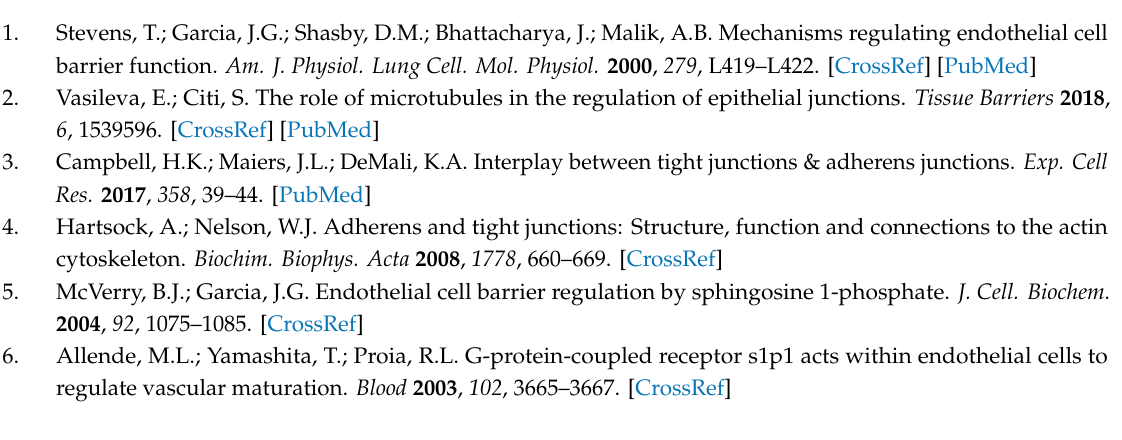
Figure S1: Dependence and reversibility of VE-cadherin assembly in HUVEC. Immunofluorescence staining of VE-cadherin in HUVEC after addition of 3 µ M S1PR1 antagonist W146, followed by removal of the added substance. Representative images from three individual experiments are shown. Pictures were taken 6 h after addition of W146 and 12 h following removal of